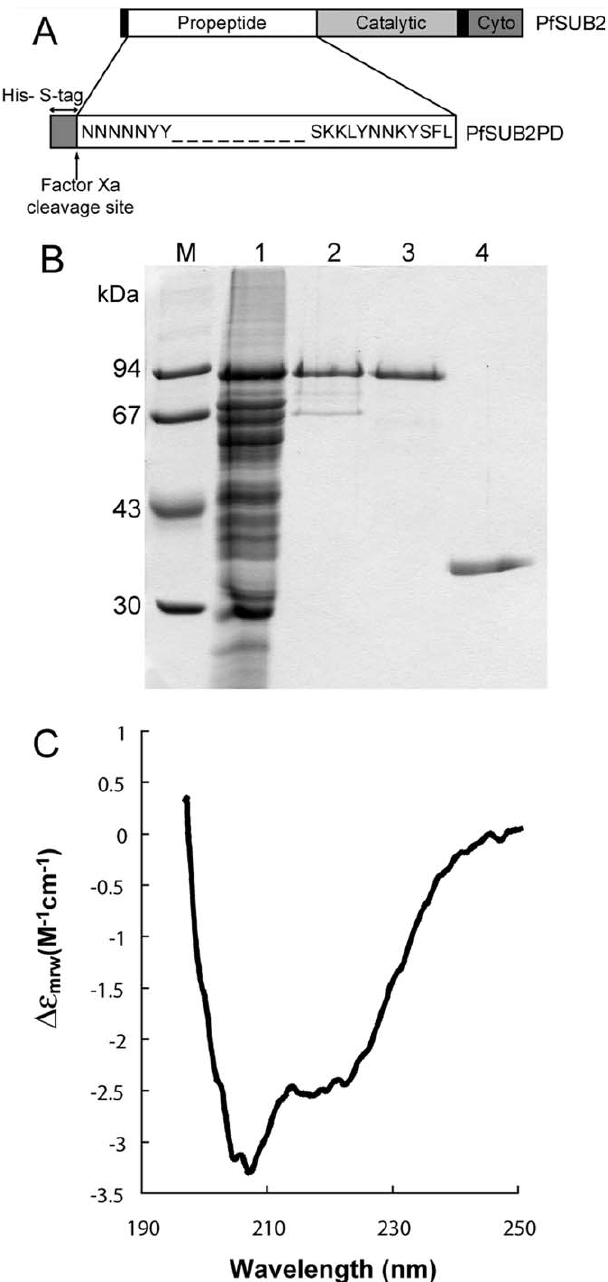
Figure 4. Recombinant PfSUB2 Propeptide Is Soluble and Structured (A) Schematic of the PfSUB2PD construct. Full-length PfSUB2 is represented with the secretory signal peptide and TMD indicated in black and the catalytic and cytoplasmic domains in shades of grey. PfSUB2PD possesses a cleavable 46-residue N-terminal fusion peptide containing a His6 and an S-tag, shown in dark grey. (B) Coomassie-stained SDS PAGE gel showing stages in the purification of PfSUB2PD. Lane 1, Ni-NTA agarose eluate enriched in PfSUB2PD; lane 2, peak fraction from Superdex 200 gel filtration of previous lane in 8 M urea; lane 3, peak fraction from the final RP-HPLC step; lane 4, purified PfSUB1 propeptide (PfSUB1PD). Lane M contains molecular mass markers, the sizes of which are indicated. (C) Far-ultraviolet CD spectrum of purified refolded PfSUB2PD. Deconvo- lution of the spectrum obtained calculated secondary structure values of 24% a -helix, 23% b -sheet, 21% reverse turn, and 32% random coil. DOI: 10.1371/journal.ppat.0010029.g004